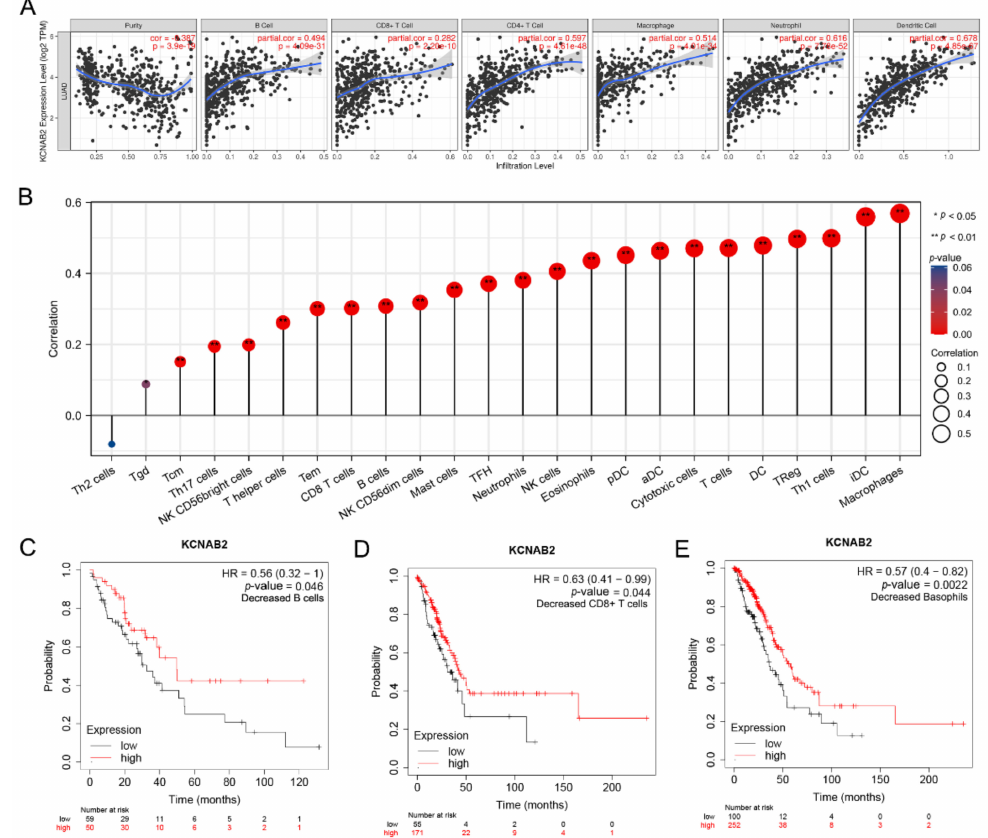
Figure 8. The relationship between KCNAB2 expression an immune cell infiltration. ( A ) The expression level of KCNAB2 is positively correlated with the infiltration of different immune cells using the TIMER database. ( B ) KCNAB2 expression has a significant correlation with the infiltration of immune cells in LUAD using the ssGSEA method. ( C – E ) Correlations between KCNAB2 expression and overall survival in different immune cell subgroups in LUAD patients were estimated by Kaplan– Meier